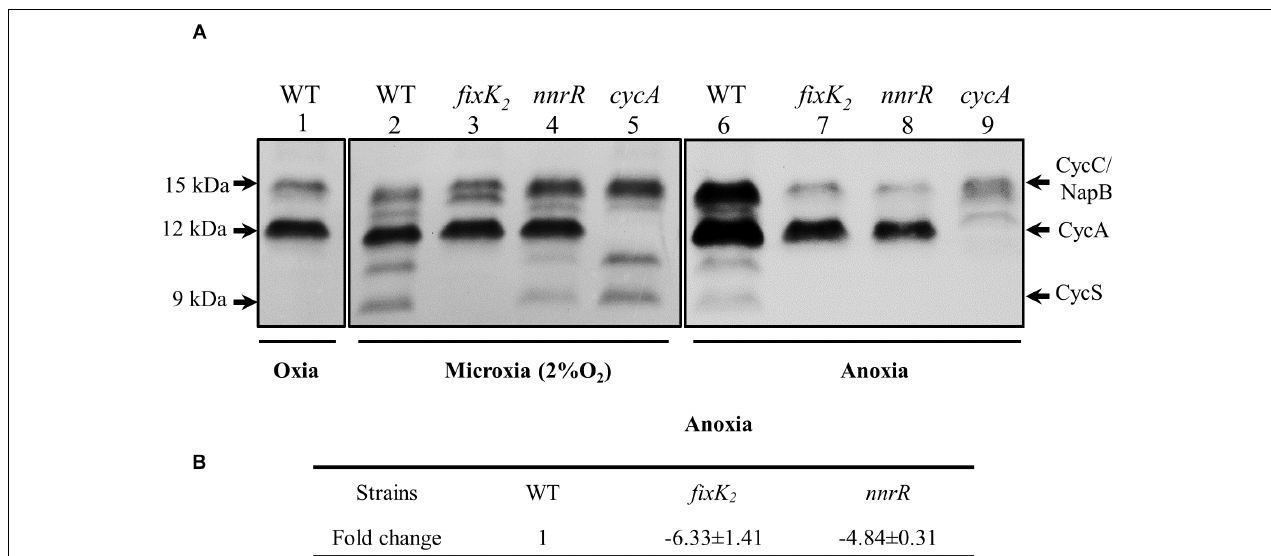
FIGURE 3 | The regulatory proteins FixK 2 and NnrR are involved in the control of cycA expression. (A) Profile of heme-stained soluble proteins from B. diazoefficiens WT, and fixK 2 , nnrR , and cycA mutants. Cells were cultivated during 24 h in YEM medium in the absence (oxic, and microoxic [2% O 2 ] conditions) or in the presence (anoxic denitrifying conditions) of 10 mM of KNO 3 . 50 µ g of soluble proteins were loaded per lane. Heme stained c -type cytochromes identified previously are specified at the right margin and their predicted molecular mass at the left. Each panel corresponds to different sections of the same gel (soluble fractions isolated from oxically and microoxically grown cells; Supplementary Data Sheet S2A ) or a different gel (soluble fractions of cells grown in anoxic denitrifying conditions; Supplementary Data Sheet S2A . (B) qRT-PCR analyses of cycA in the WT, and fixK 2 and nnrR mutants. Six parallel reactions were performed with cDNA retro-transcribed from RNA isolated from cells grown in anoxic denitrifying conditions (at least two independent biological replicates per strain). Fold change (FC) values refer to the relative expression in the fixK 2 and nnrR mutants compared to the WT. anoxia, anoxic denitrifying